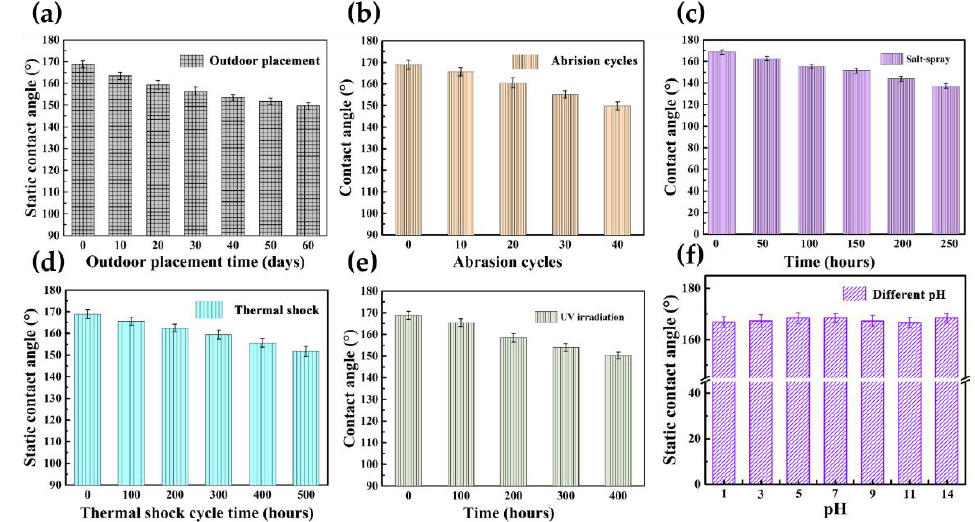
Figure 3. CAs of the PTFE + 30%SiO 2 super water-repellent coating under different conditions: ( a ) outdoor placement, ( b ) abrasion, ( c ) salt-spray, NaCl solution, ( d ) thermal shock cycles, ( e ) UV irradiation, ( f ) Statistics of the CAs for the coatings with different pH value droplets.